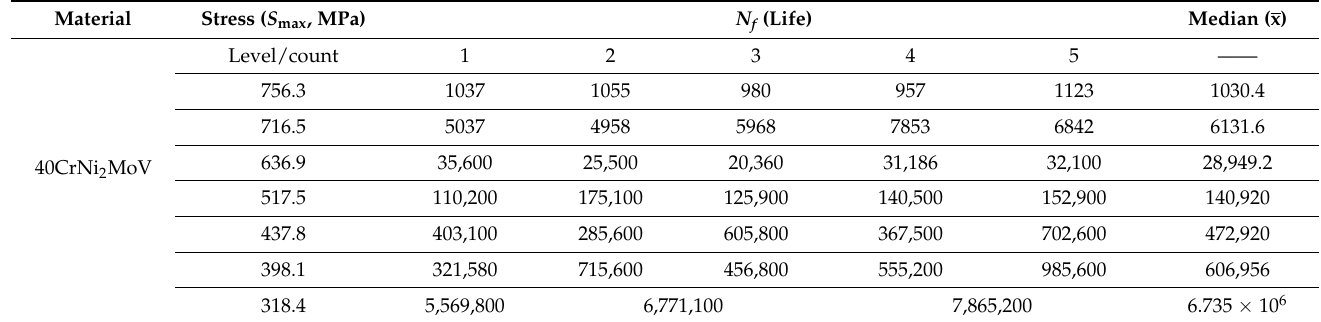
Table 4. Empirical data of different fatigue test groups for the pumphead material.